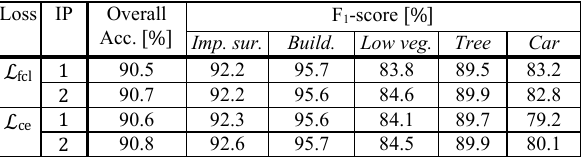
Table 2. Achieved quality metrics for the Vaihingen benchmark.